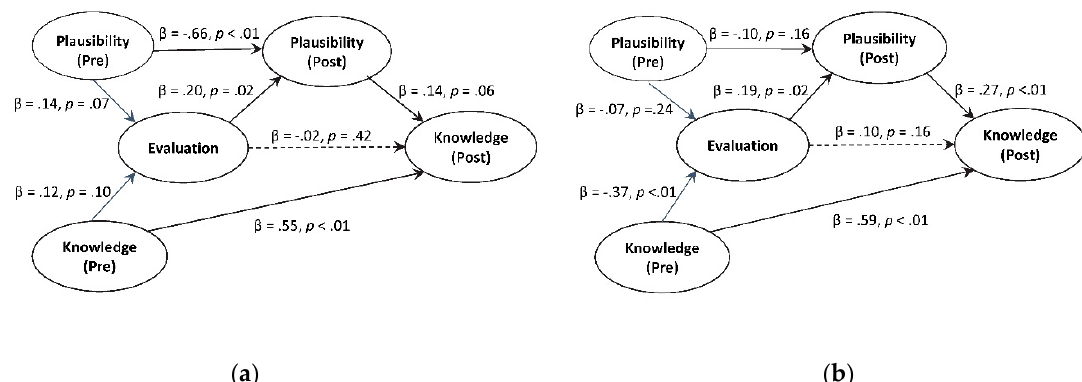
Figure 7. Comparison of pathway effect sizes between the Wetlands pcMEL ( a ) and the Freshwater baMEL ( b ). Pathway effect size values are unbiased indices that are compatible with partial least squares (PLS)-SEM and essentially equivalent to Cohen’s f 2 coefficient [34], with small effect size = 0.02, medium effect size = 0.15, and large effect size = 0.35. The dashed line indicates when effect sizes are equivalent in the two MELs. Points above and to the left of the dashed line indicated when effects sizes are greater for the Freshwater baMEL. Points below and to the right of the dashed line indicate when effect sizes are greater for the Wetlands pcMEL.